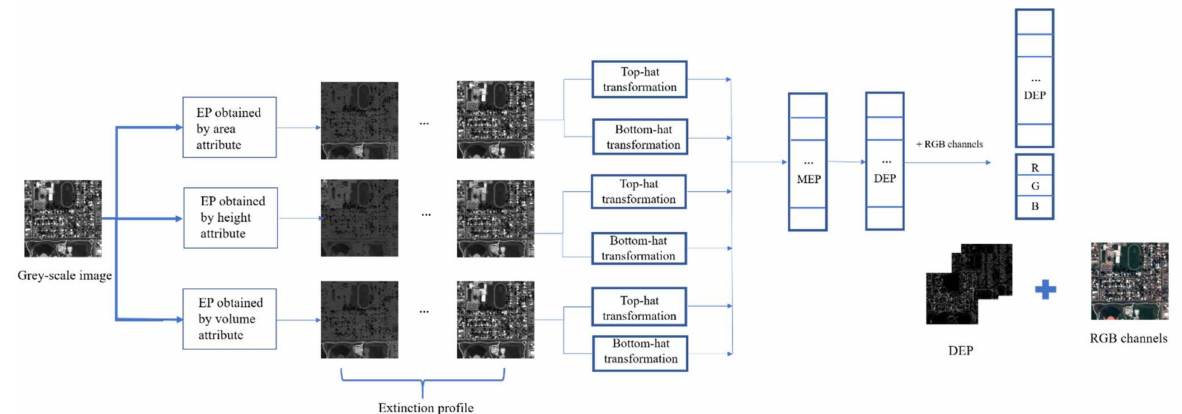
Figure 3. The framework of computation of input feature vector.